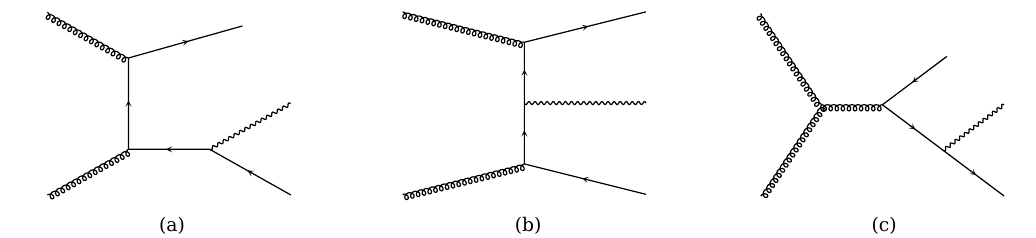
Figure 13. Diagrams for the gg → Zq ¯ q contribution to Z +jet production (diagrams where the direction of the quark line is reversed are omitted). Our factorization formula only includes the singular contributions in the expansion of diagrams (a) and (b) around the back-to-back limit of the boson and jet. There are power corrections at O ( α s ( δφ ) 0 ) from expanding diagrams (a) and (c) for the emission of a Z -boson off dijets, which are included via matching.